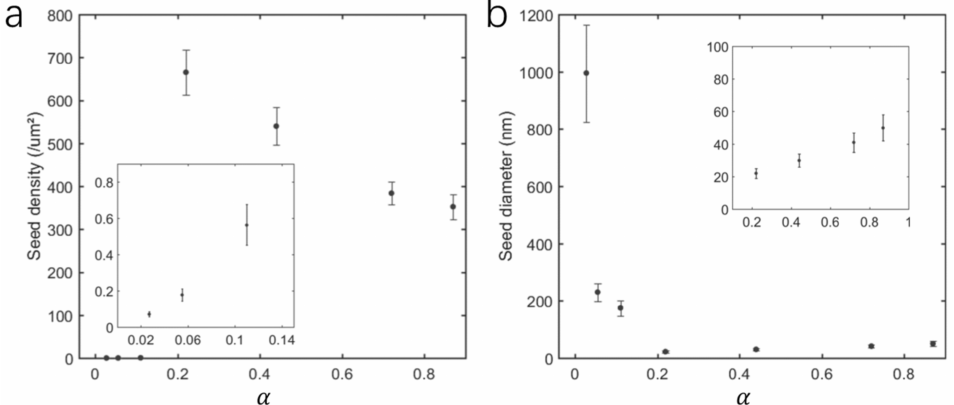
Figure 2. Variation of seed layer morphology parameters with ZnAC/PVA volume ratio α . ( a , b ) are statistics of the number density and diameter of seeds,